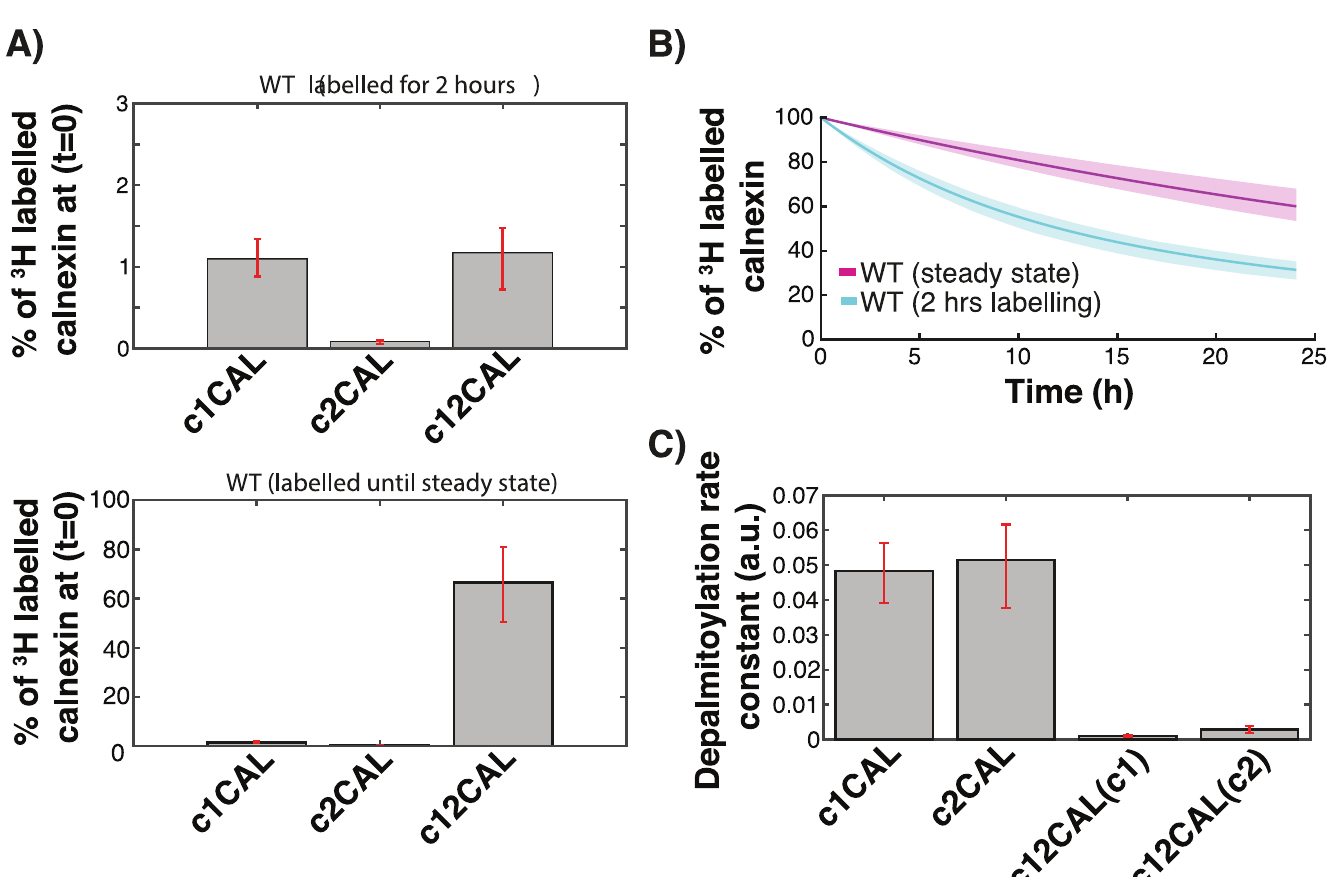
Fig 4. Prediction of depalmitoylation kinetics. A: WT calnexin was labelled with 3H-palmitate in silico either for two hrs or to reach the steady state distribution of palmitoylation species. B: The kinetics of palmitate loss starting from the two distributions in A were determined. The solid lines represent the means of the simulations of 382 models and the shaded areas are defined by the first and the third quartile of the simulations of 382 models (details of the in silico labelling experiment can be found in the Expanded View). C: The rate constants for depalmitoylation from c1CAL, c2CAL and c1c2CAL where determined. Error bars correspond to first and third quartile of the simulations of 382 models.